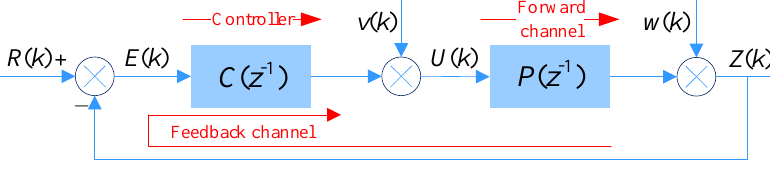
Figure 4. Typical closed-loop control system.